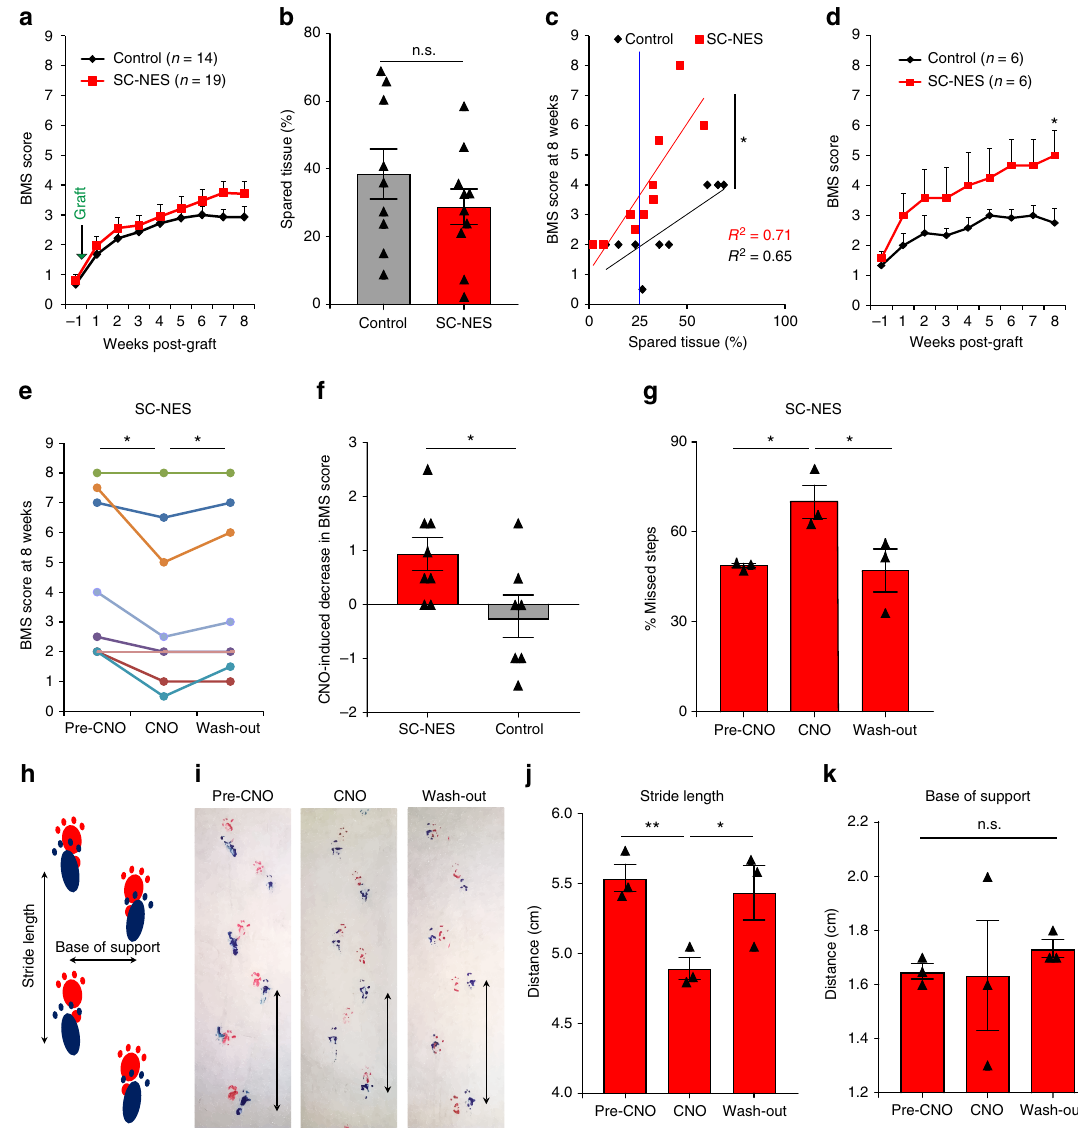
Fig. 5 Human SC-NES cells form a relay system in the injured SC. a Hindlimb locomotion: BMS scores before and after dorsal SC hemisection in animals subject to cell implant ( n = 19) and in controls ( n = 14). The fi rst time point indicates the locomotor performance one week after injury and three days prior to cell engraftment. b Spared tissue quanti fi cation in control and treated animals. c Correlation analysis of spared tissue percentage and the BMS score at 8 weeks in a subgroup of animals. Each symbol represents an animal. The correlation shows a signi fi cant difference between SC-NES cell recipient animals and the control group. The blue line indicates the percentage of spared tissue equal to 25%. Animals on the right of the blue line were selected for a strati fi cation of the original cohort of animals shown in a . d BMS scores including SC-NES cells recipient animals ( n = 6) and control animals ( n = 6) with a percentage of spared tissue greater than 25%. e BMS score of SC-NES cells recipient animals at 8 weeks. Each dot represents an animal. SC-NES cells were transduced with the hM4Di-mcherry construct prior to surgical implantation. Animals were scored before CNO administration (Pre-CNO), 30 min after CNO administration (CNO), and 24 h after (wash-out). f The per-animal change in BMS score before and 30 min after CNO administration is plotted for SC-NES cell-treated and control animals. g Grid-walking test: percentage of missed steps of SC-NES cell recipient animals before CNO treatment, under CNO effect and 24 h after drug administration (wash-out). h Schematics of the foot print test. Base of support and stride length were measured. i Representative images of SC-NES cell recipient animals footprints before, during and after CNO injection. Black arrows indicate the stride length for one representative step in all three conditions. j Quanti fi cation of stride length in SC-NES cell recipient animals pre-CNO, upon CNO treatment and after drug wash-out. k Quanti fi cation of base of support distance. Data are expressed as means ± s.e.m. (* P < 0.05; ** P < 0.01; Student ’ s t -test for comparisons between two groups and repeated measures ANOVA for BMS